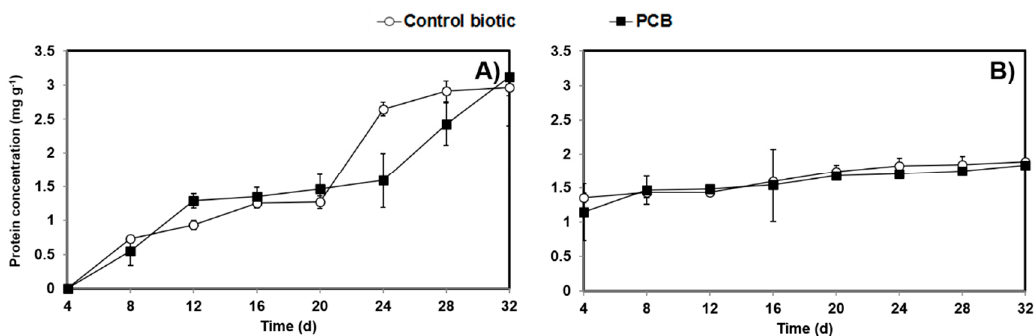
Figure 2. Concentration of protein in the culture medium of treatments with and without PCB: ( A ) A. niger MXPE6; ( B ) fungal consortium ( A. niger MXPE6 + A. niger MX7). Data are given as means ± standard error; n =